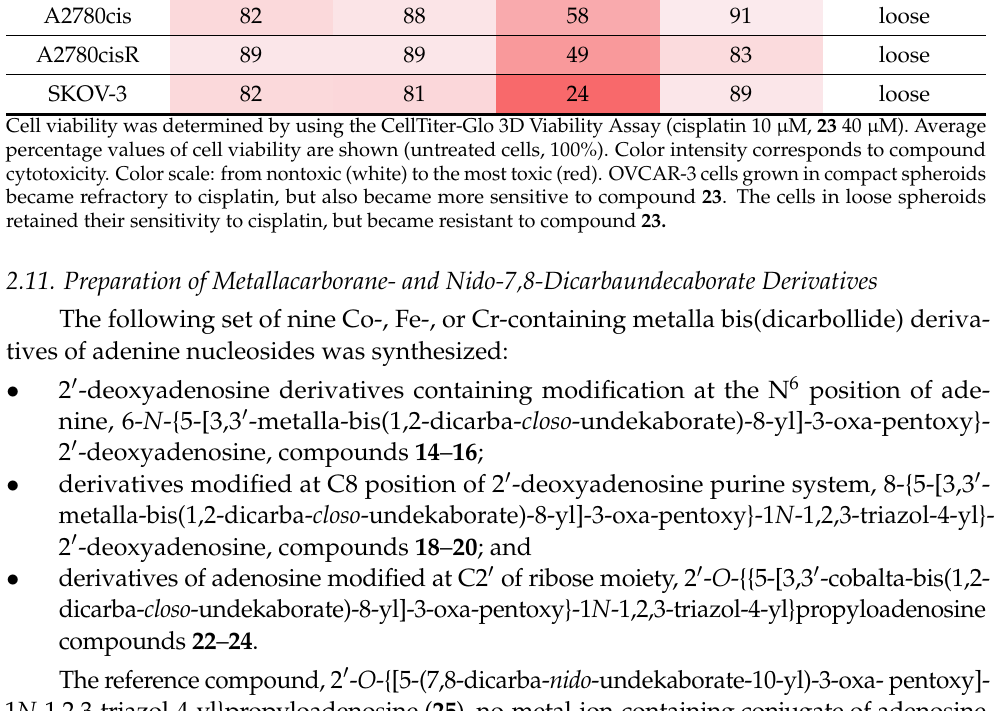
Table 2. Cytotoxicity of compound 23 in different ovarian carcinoma cell lines depending on their cisplatin (10 µ M) sensitivity and form of growth—monolayer or spheroids. Measurements of cellular ATP level. Cisplatin Compound 23 Spheroid Cell Line StructureAdherent Spheroids Adherent Spheroids OVCAR-3 40 100